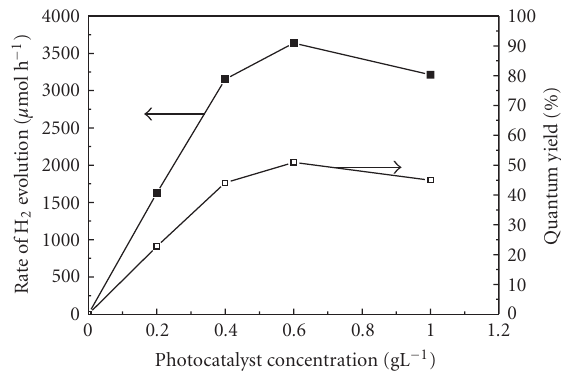
Figure 11: Determination of optimum amount of photocatalyst